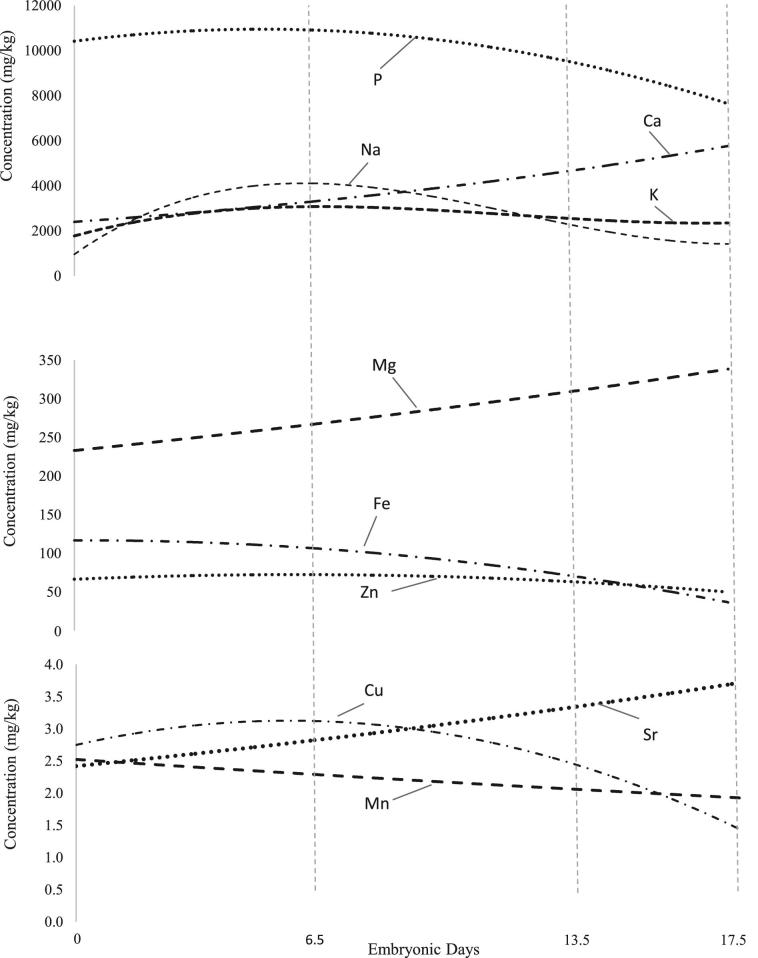
Regression lines of yolk mineral concentrations against time. Regression lines for P, Fe, Zn, and Cu are binomial. Regression lines for Ca, Mg, Mn, and Sr are exponential. Regression lines for Na and K are trinomial.